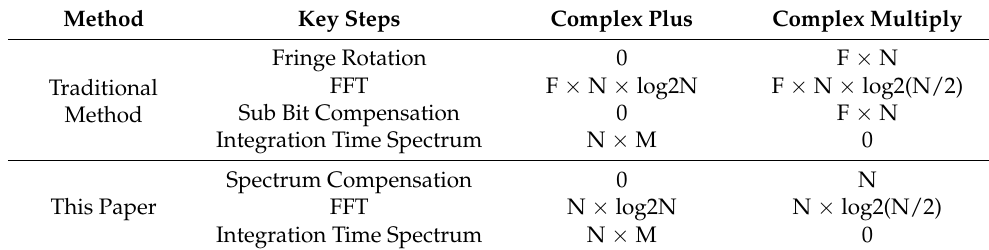
Table 1. Computation burden of the two methods in each iteration.